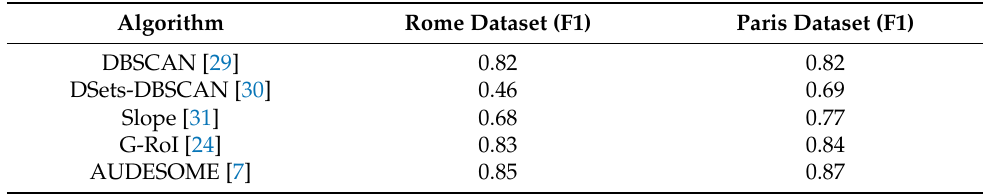
Table 1. Results comparison for topic discovery task.